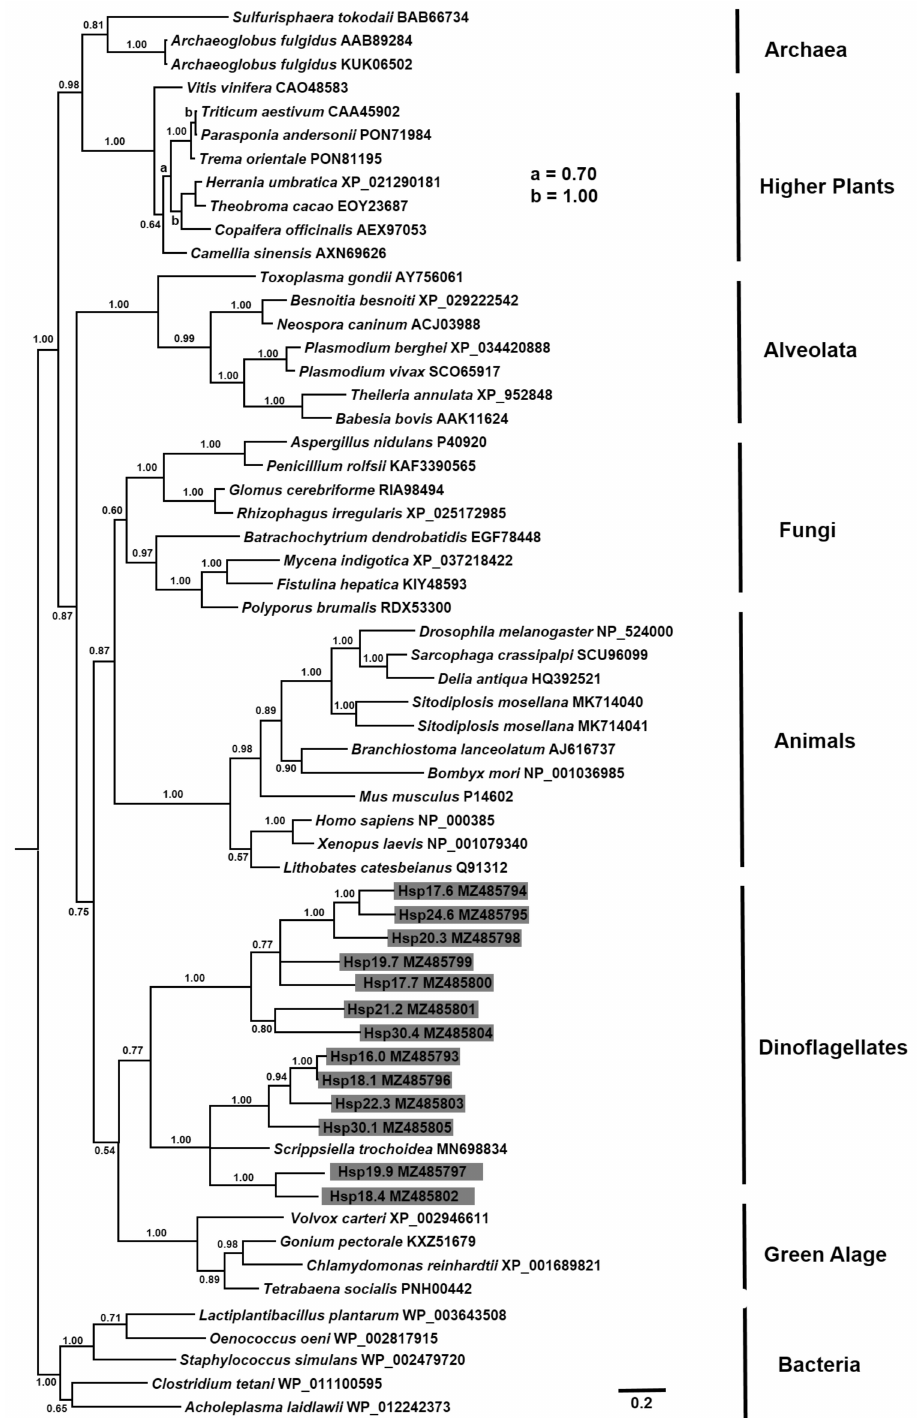
Figure 2. Phylogenetic reconstruction inferred from sHsp amino acid sequences using the Bayesian- Inference (BI) method. Numbers at the nodes represent BI posterior probabilities. GenBank accession number of each sequence is noted following the species name. The 13 newly yielded sequences are present as gene name following GenBank accession number and highlighted in gray